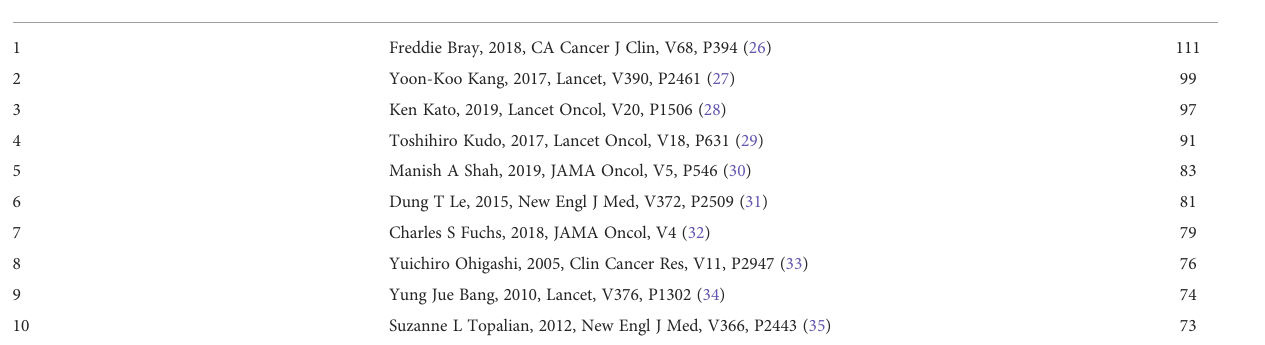
TABLE 6 The top 10 co-cited reference from 2012 to 2021.